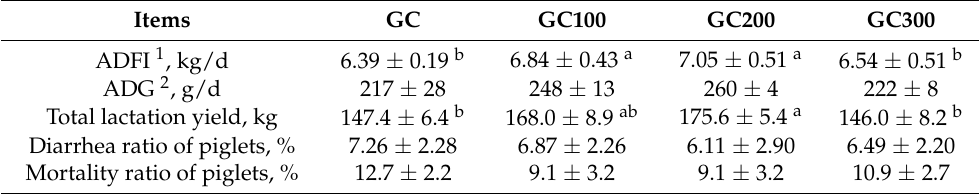
Table 2. Effects of SI and APS mixture on the production performance of lactating sows.